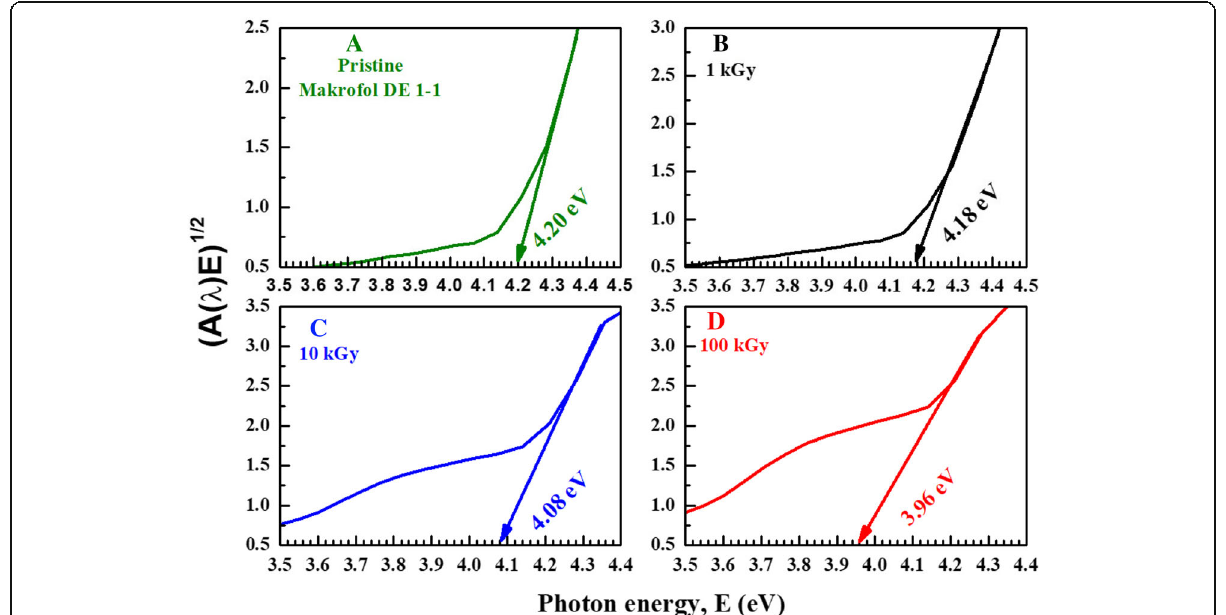
Fig. 9 Variation of ( A ( ν ) E ) 0.5 with ( E ): a pristine, b 1 kGy, c 10 kGy, and d 100 kGy Makrofol DE 1-1 samples irradiated with gamma rays